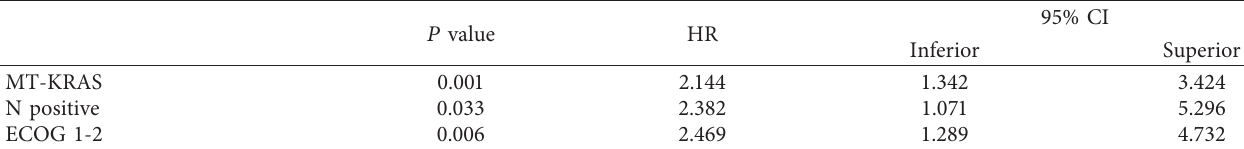
Table 3: Predictive factors of survival by Cox multivariate